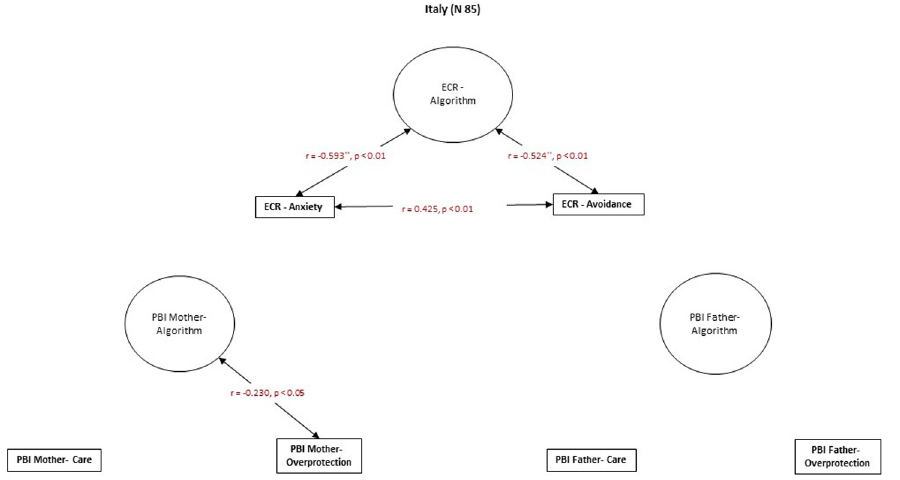
Fig 6. Spearman’s r correlations between ECR and PBI in the Italian